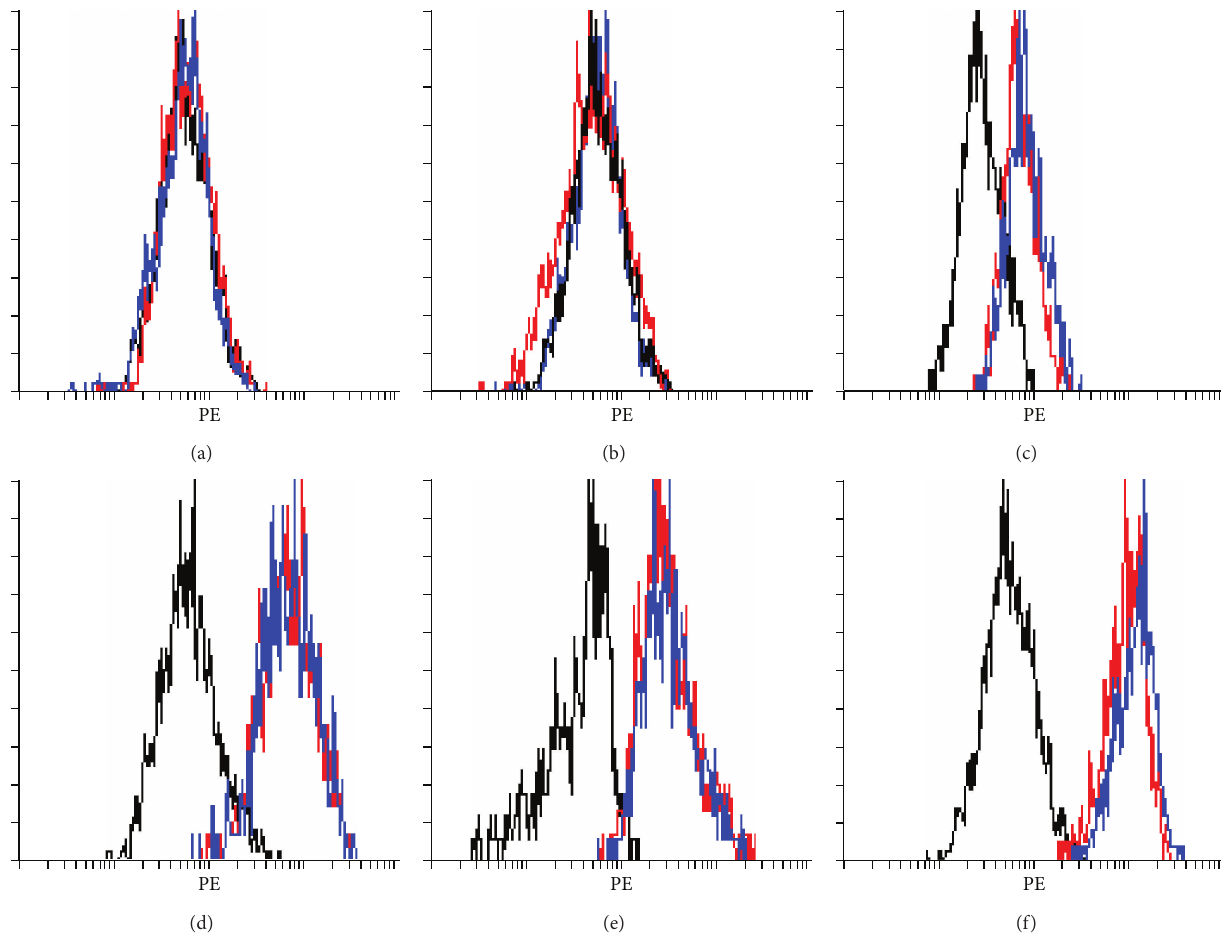
Figure 3: Immunophenotypic expression of control and HA treated MSCs. Immunophenotypic expression of MSCs cultured in either standard culture media or HA media. Each of the histograms depicts the IgG iso-type control (black dashed lines), control media (red dashed lines), and HA media (blue dashed lines). Maintenance of MSC profile was confirmed with the lack expression in the haematopoietic markers CD34 (a), CD45 (b), and positive expression of CD73 (c), CD90 (d), and CD105 (e) in both the control and HA treated MSCs. CD44 (f), the major receptor for HA, showed no major increases in immunophenotypic